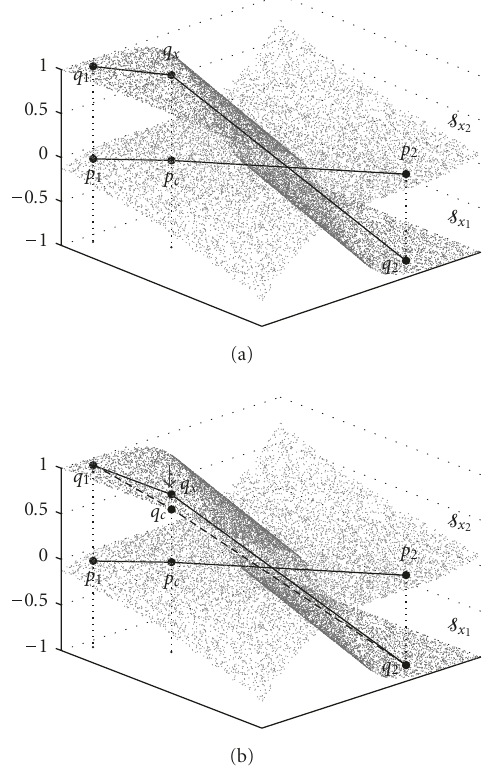
Figure 8: An example of gpICA method. The surface S x formed using the fake plane S x after the transformation. Because μ < 1, q x is pulled to a new posi- tion near q c